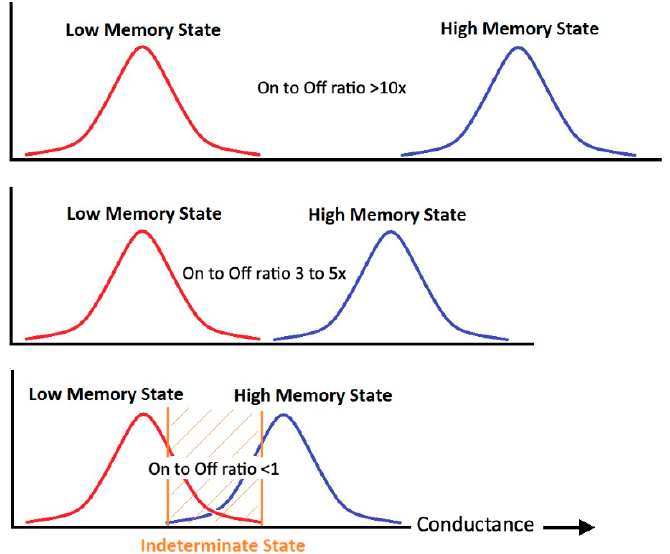
Figure 7. An illustration of the on/off ratio requirements for memory cells. This on/off ratio is defined in terms of the “read” mechanism. In the example presented in this review, the on/off ratio relies on current or conductance changes but could also be a change in resistance. The measurable indicator of state change would be along the x-axis. There is a statistical variation in the conductance in both the on and the off states, between memory cells in a memory array, and this results in a range of ”low” and “high” conductance states associated with the low and high spin states. If the on/off ratio is reduced too much, an indeterminate state can occur, where it is not clear which state the memory cell is in.